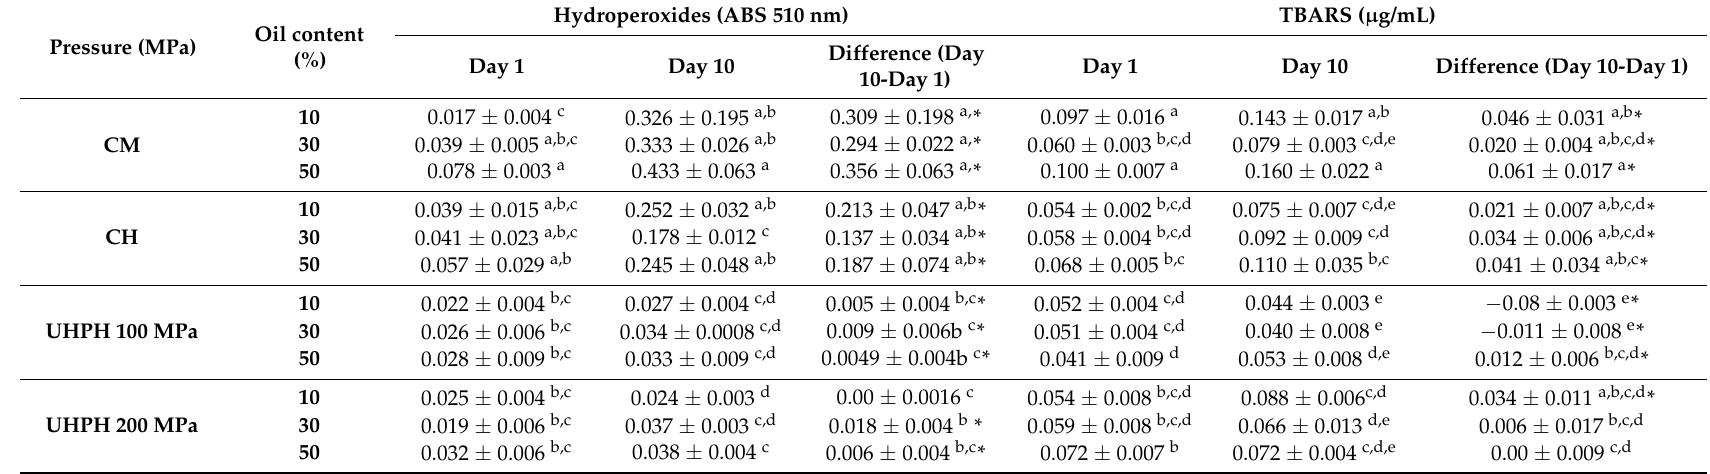
Table 3. Mean ± standard deviation of the amount of hydroperoxides (absorbance at 510 nm) and thiobarbituric acid-reactive substances (TBARS) ( µ g/mL) of O/W emulsions containing 4% ( w / w ) of whey protein isolate plus sunflower and olive oils (10%, 30% and 50%) and prepared by colloid mill (CM), conventional homogenization (15 MPa) and ultra-high pressure homogenization at 100 and 200